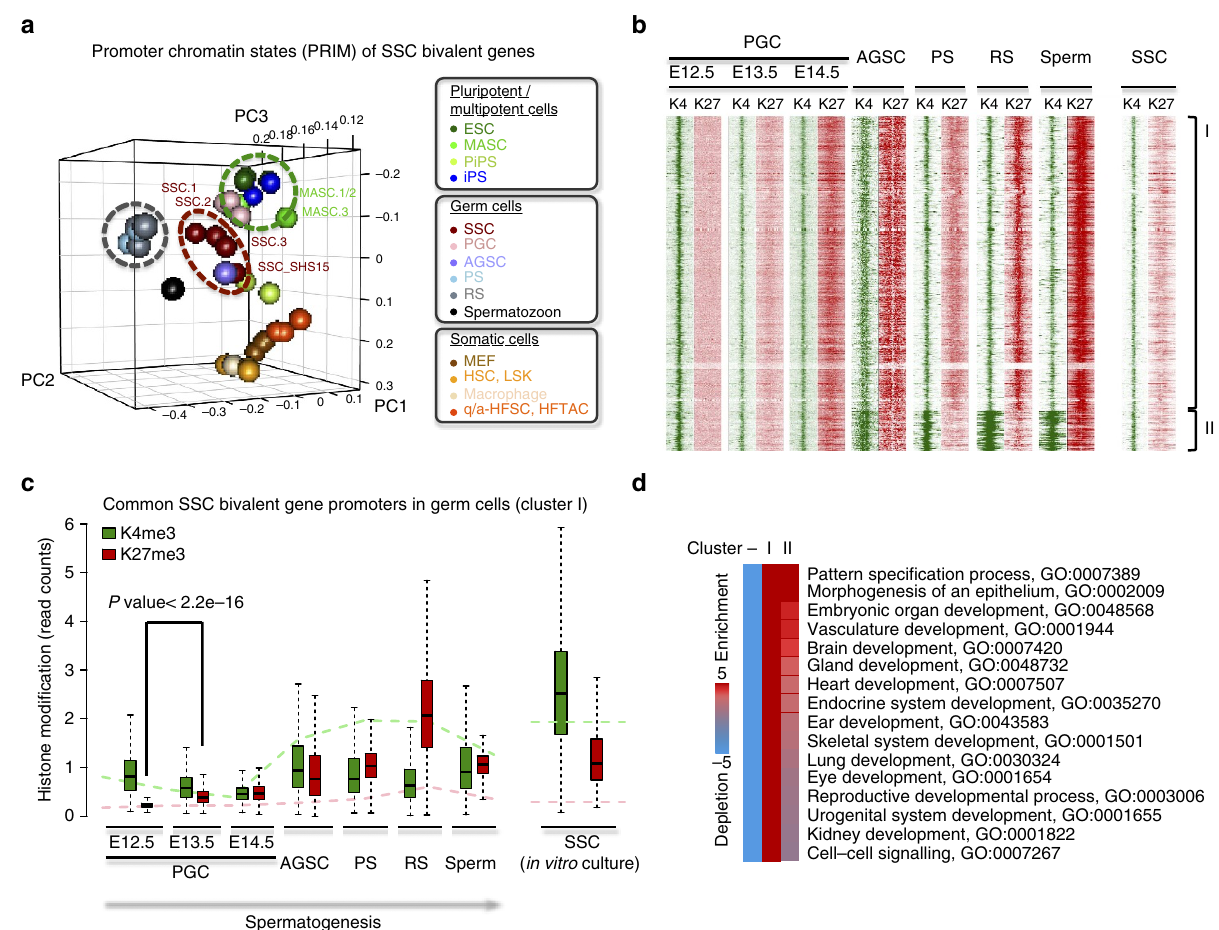
Figure 6 | SSCs maintain consistent promoter bivalency with germ cells in vivo . ( a ) Three-dimensional (3D) PCA plot based on PRIMs of all promoters with K4me3 þ K27me3 bivalent histone modifications in SSCs. Different cell types are distinguished by colours as in Fig. 1. ( b ) k -means clustering of SSC bivalent genes by similarity of K4me3 and K27me3 profiles at promoters. Green, K4me3; red, K27me3. Cluster I, 2,644 genes; cluster II, 372 genes. ( c ) Histone modification profiling at promoters of all cluster I genes as grouped in b . Germ cells include those isolated from testis by fluorescent-activated cell sorting (left) and SSCs cultured in vitro (right). y axis, average read count within promoter region. Green box, K4me3 modification; red box, K27me3 modification. The bottom and top of the boxes indicate the 25th and 75th percentiles, the central bars indicate medians and whiskers indicate non-outlier extremes. P values were calculated using Wilcoxon tests. Dashed green line, average read count of K4me3 modification at all promoters in each cell type; dashed red line, average read count of K27me3 modification at all promoters in each cell type. ( d ) GO enrichment using iPAGE. Genes are grouped by promoter K4me3 and K27me3 profiles as in b